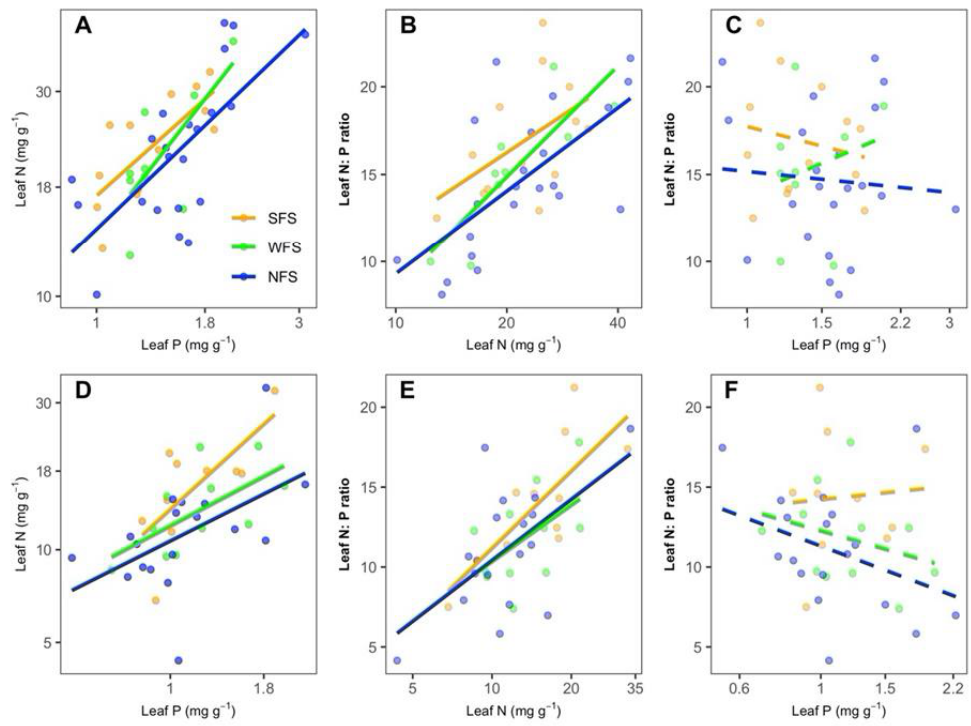
Figure 3. Linear regressions between leaf [N] and [P], between leaf [N] and leaf N:P ratio, and between leaf [P] and leaf N:P ratio in Hezuo ( A – C ) and Maqu ( D – F ). Solid and dashed lines indicate significant and non-significant regressions, respectively. SFS, WFS, and NFS represent south-, west-, and north-facing slope aspects, respectively. Variables are in log10 scale. Significantly higher richness of all species and forbs and lower richness of legumes were found on the NFS than on the SFS and WFS (Figure 4A – D); however, the richness of graminoids and plant coverage for each PFG and for all species did not differ significantly among the slope aspects (Figure 4E – H).